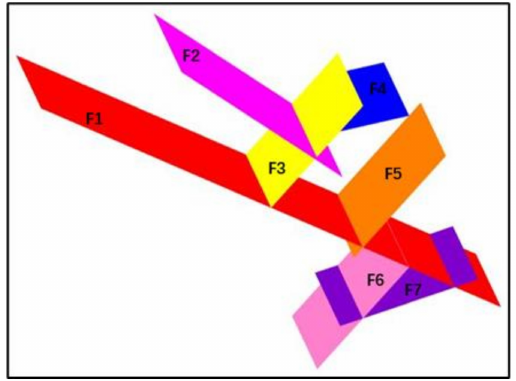
Figure 17. Example of a complex fault model.